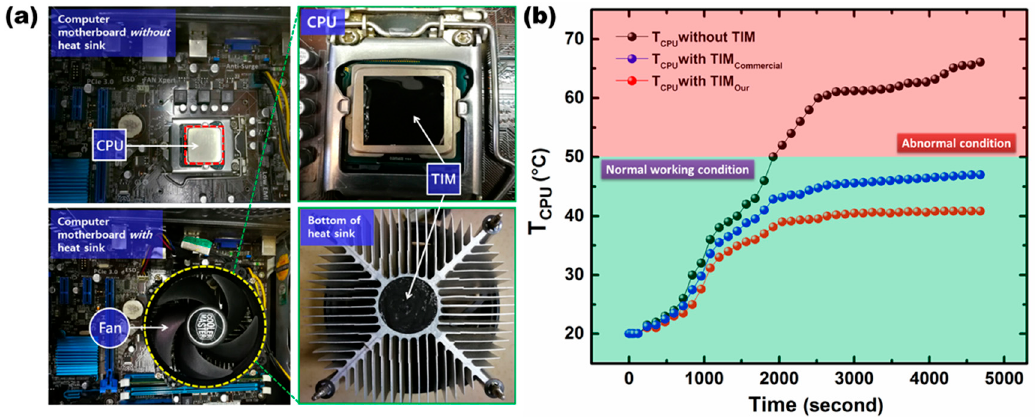
Figure 5. Changes in computer CPU cooling with the temperature of (GNS-MWCNT)@AgNPs/PVA TIM and a commercial TIM were